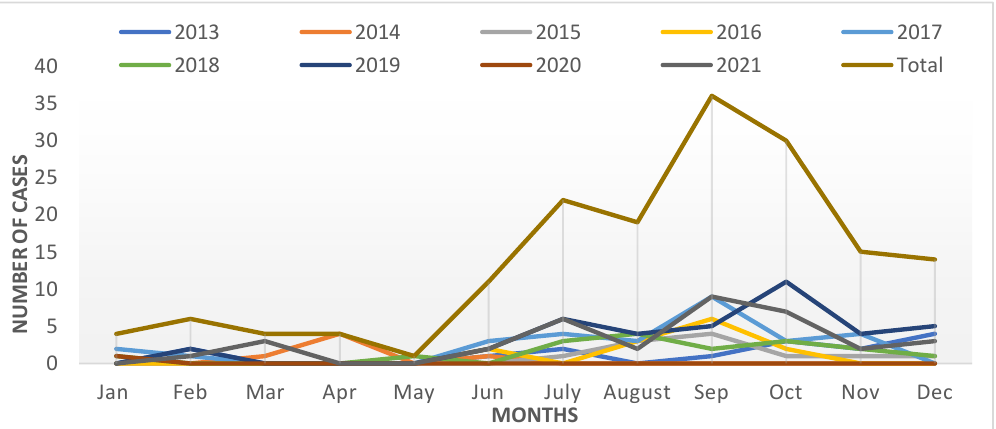
Figure 2. Monthly trends of reported dengue cases between 2013 and 2021 in Qatar.